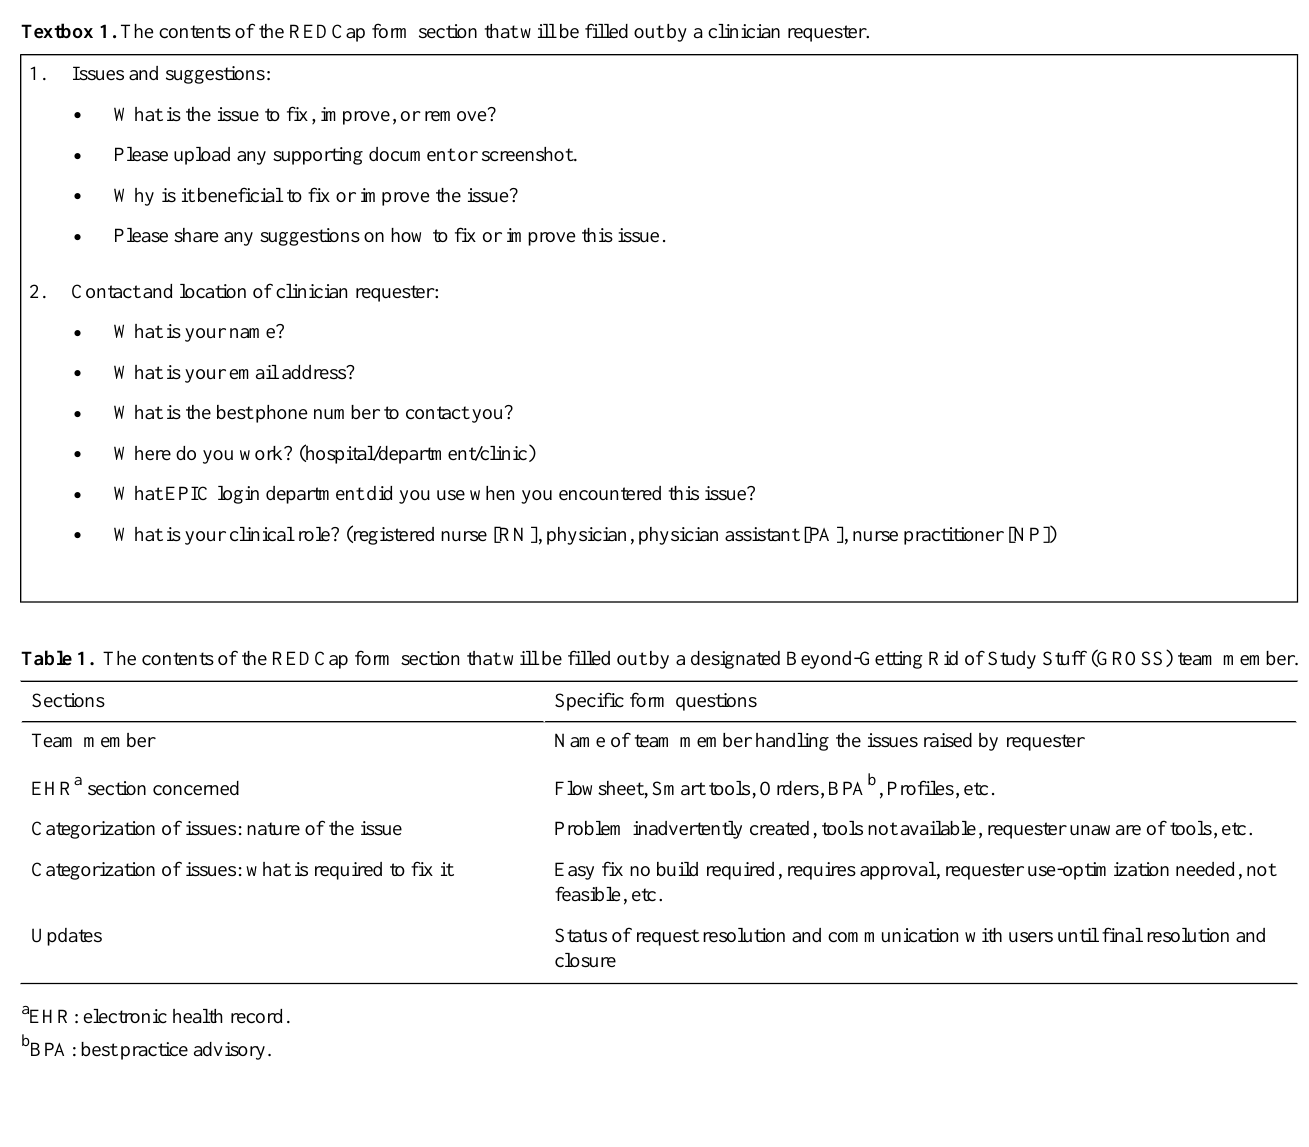
2 sections: The first section contains questions relating to the potential issues raised by the frontline clinician and specific issue, location where the issue occurred, and best way to follow up with requesters (see Textbox 1 for form content and